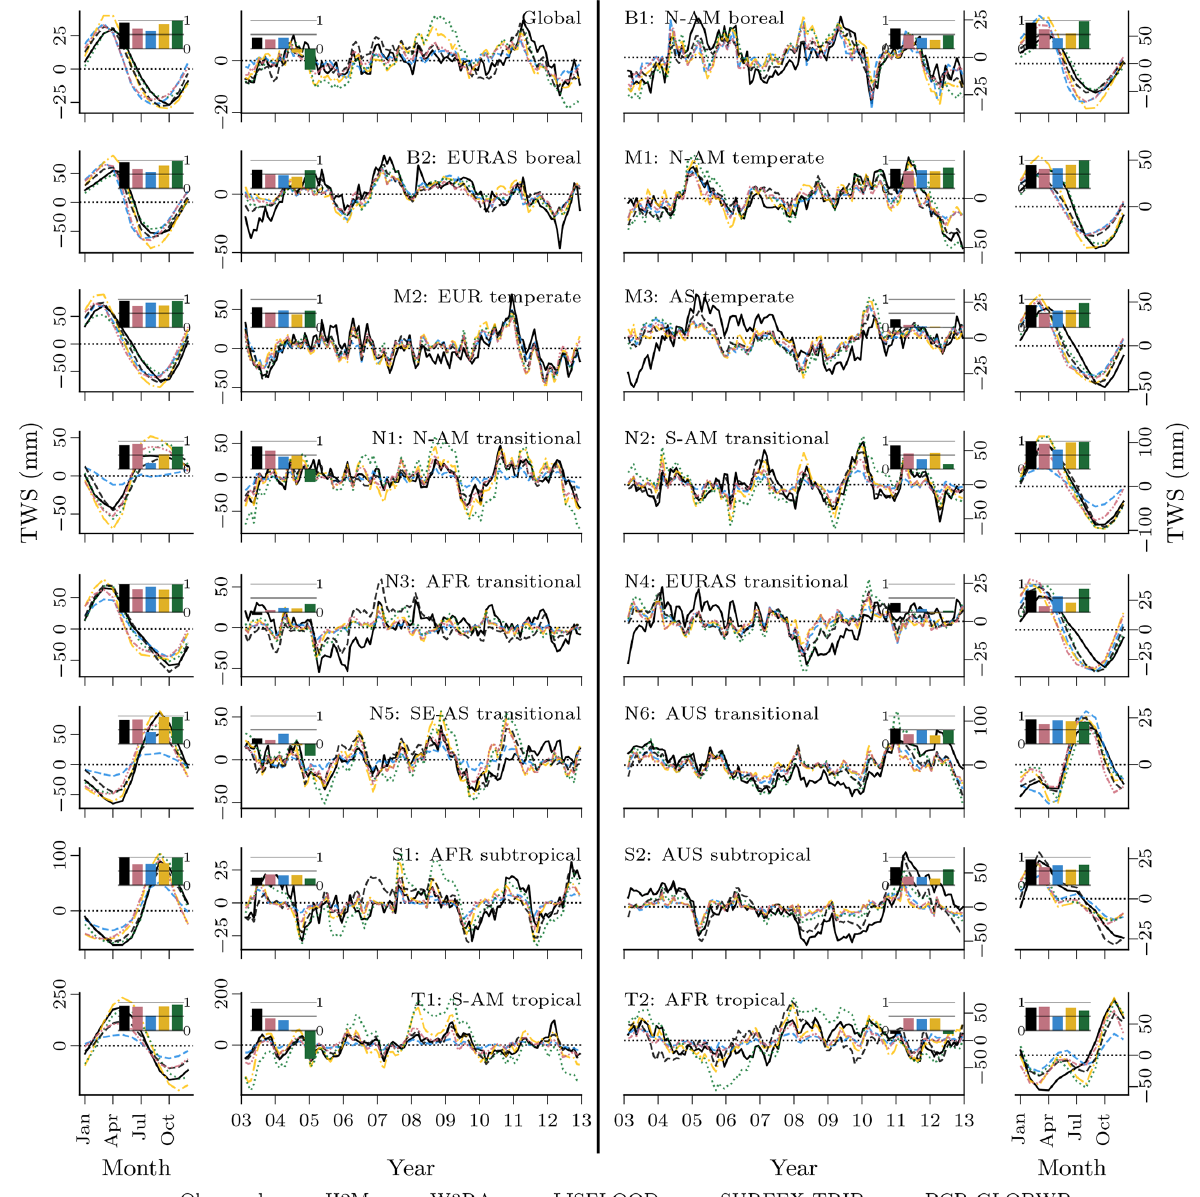
Figure B1. Comparison of the hybrid hydrological model (H2M) and a set of process-based global hydrological models (GHMs) of the terrestrial water storage mean seasonal cycle (TWS MSC ; outer columns) and interannual variability (TWS IAV ; center columns) in millimeters for hydro-climatic regions (Fig. 2). The time series were aggregated using the cell-size-weighted mean across all grid cells in the respective region. The inset axes show the Nash–Sutcliffe model efficiency (NSE) of each model with the same color-coding as the time series. Note that the y scale differs between